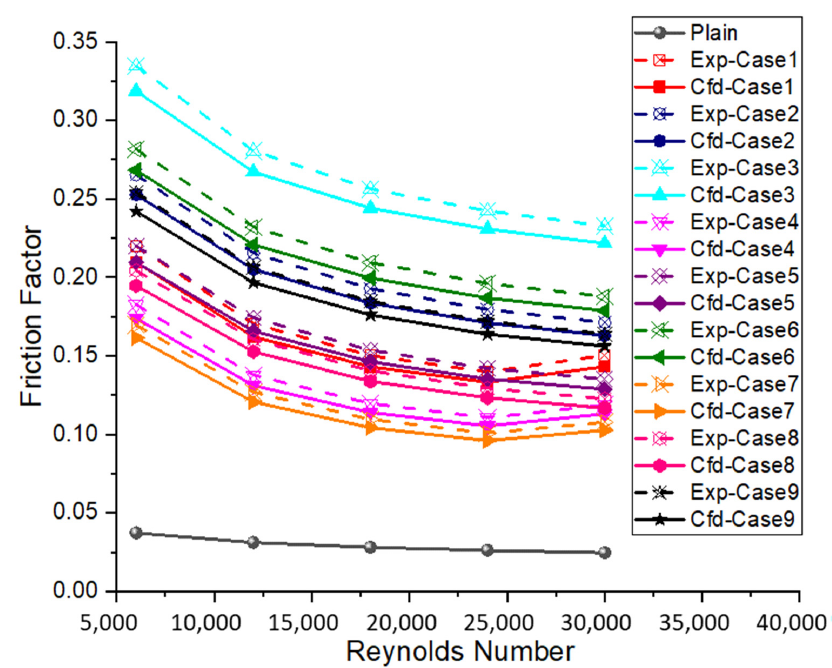
Figure 10. Augmented values of friction factor over Reynolds Number.